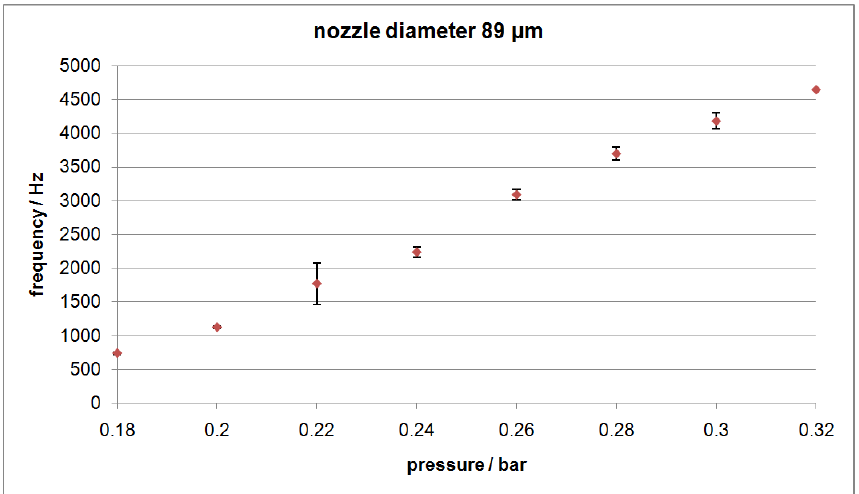
Figure 10. Droplet generation frequency as a function of the actuation pressure (one channel setup, nozzle chip (#6); number of measurements per data point, N =